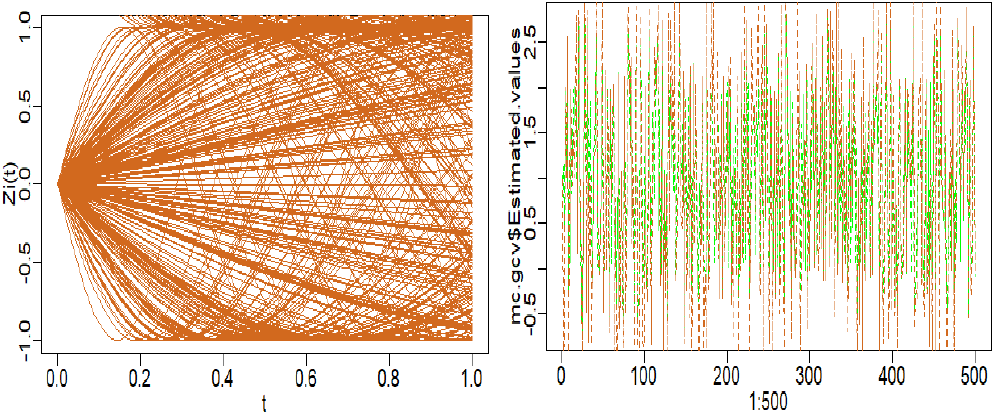
Figure 2. On the left plot: 500 realizations of the functional random variable Z , and on the right plot: the predicted response (in abscissa) compared to the true response (in ordinate).